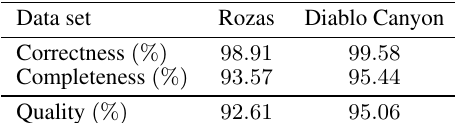
Table 3. Statistical results of the evaluation.